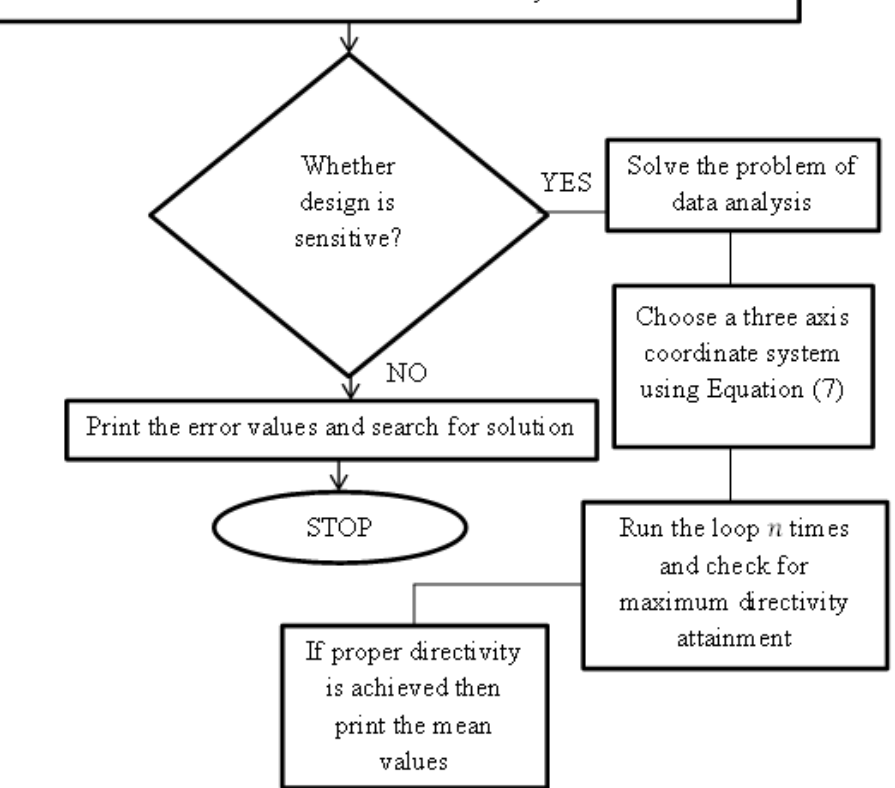
Figure 2. Integration of underwater vehicle using hydrophone.